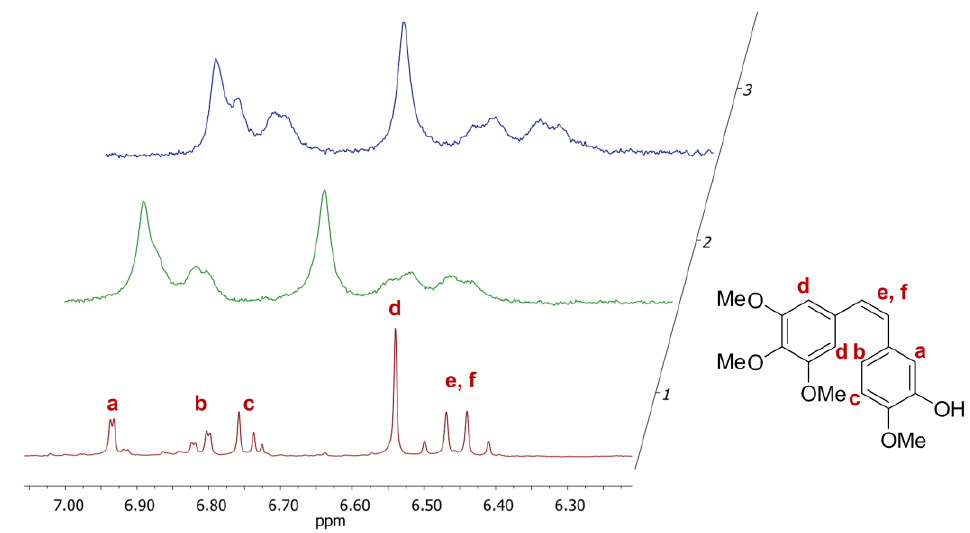
Figure 9. 1 H NMR spectra for the aromatic and double bond regions of CA-4 in CDCl 3 (1), CA-4 encapsulated in TEGMA- ran -FA (2), and PEGMA- ran -FA (3) in D 2 O.